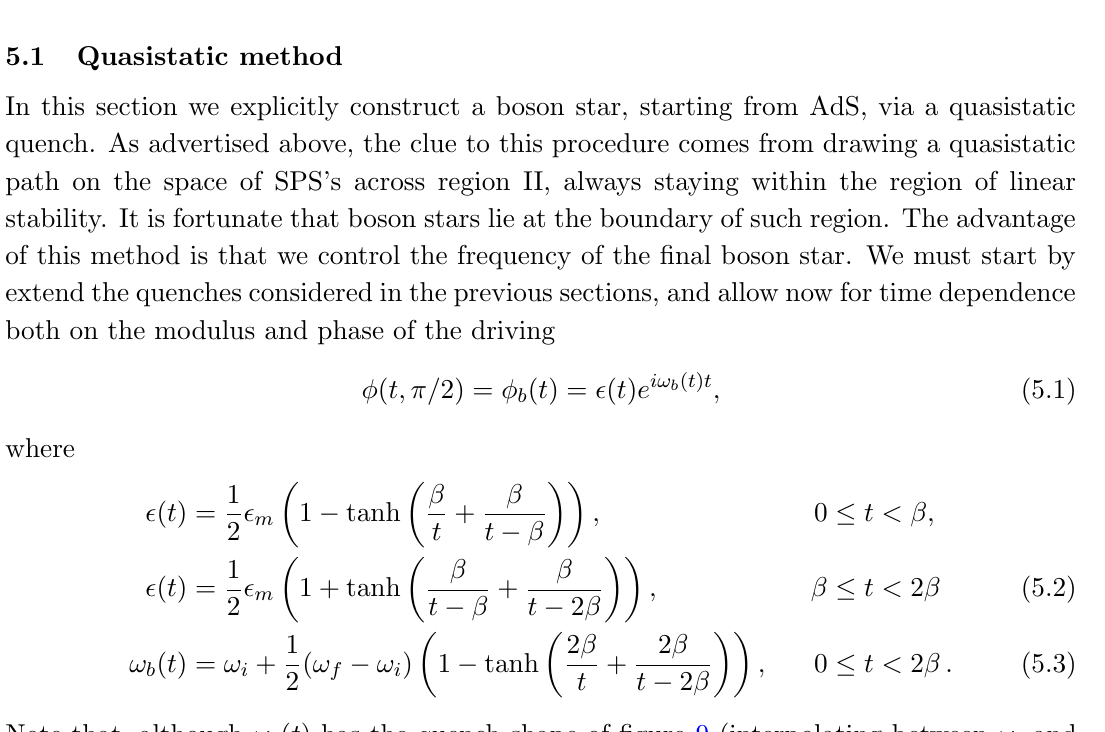
Figure 19 . The functions (cid:15) ( t ) and ! ins ( t ) employed to build a boson star starting from